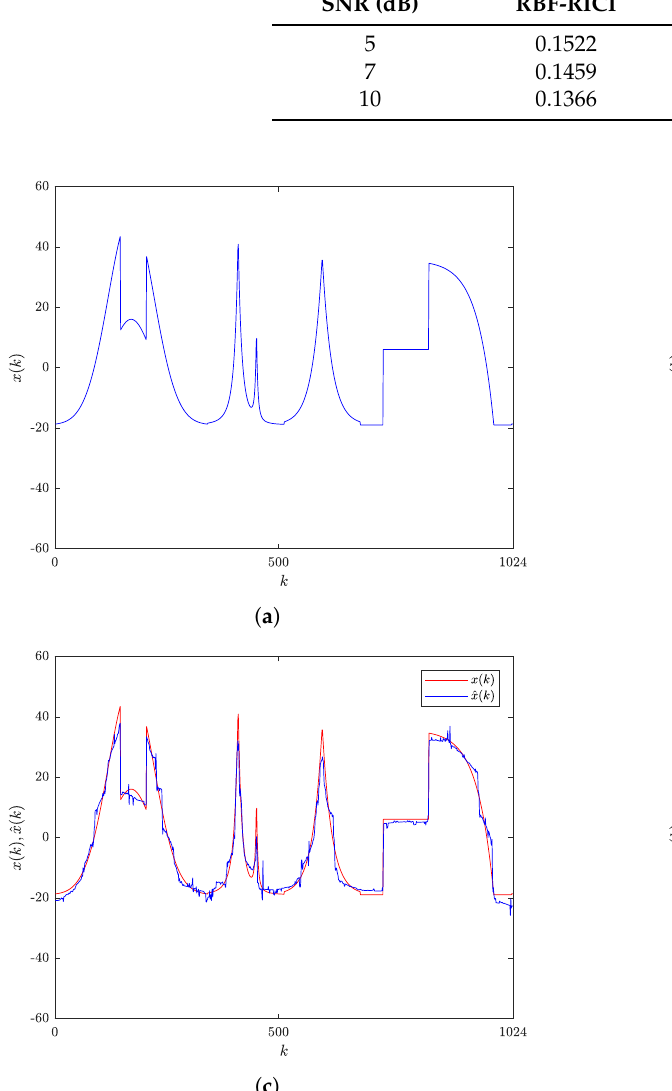
Figure 5. Piece-Regular signal: ( a ) Original signal. ( b ) Noisy signal (SNR = 7 dB). ( c ) Original and RBF-RICI filtered signal ( Γ = 1.44, R c = 0.81). ( d ) Filtering